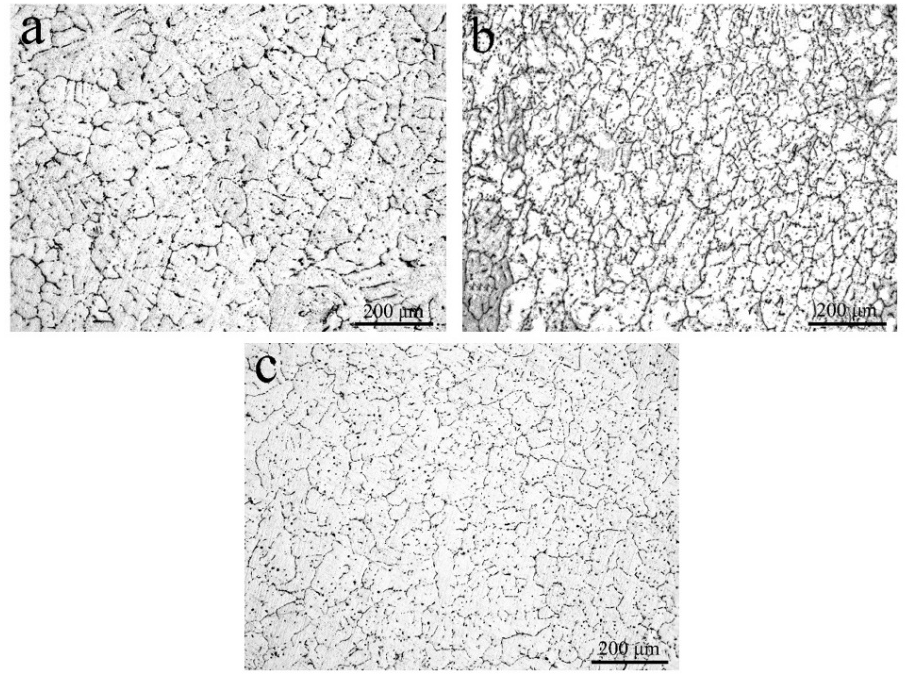
Figure 1. Microstructure of the as-homogenized ingot alloys: ( a ) Al-0.2Fe-0.06Cu; ( b ) Al-0.2Fe-0.06Cu-0.1La; ( c ) Al-0.2Fe-0.06Cu-0.15La. Table 1. Average grain size of the as-homogenized ingot alloys with different La contents. Alloy